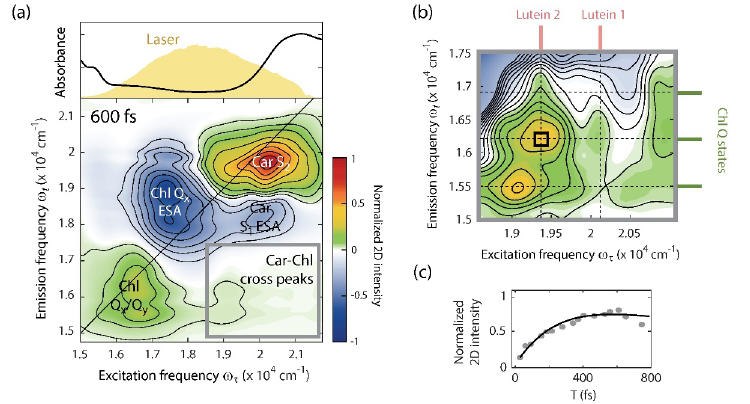
Fig. 2. (a) Absorptive 2D spectrum of LHCII at a waiting time ( T ) of 600 fs. Top panel shows the linear absorption of LHCII in the detection range of 2DES (black line) overlaid with the ultrabroadband laser spectrum (yellow area). (b) Zoom-in of Car-Chl cross peak region of the 2D spectrum (labelled with grey box in (a)). Coloured sticks indicate the pigment energy levels identified by second-derivative analysis of the linear absorption spectrum. (c) Representative waiting time trace of Car-Chl cross peaks, obtained at the peak position labelled in (b) with a black box. The exponential fit shows a 120-fs rise